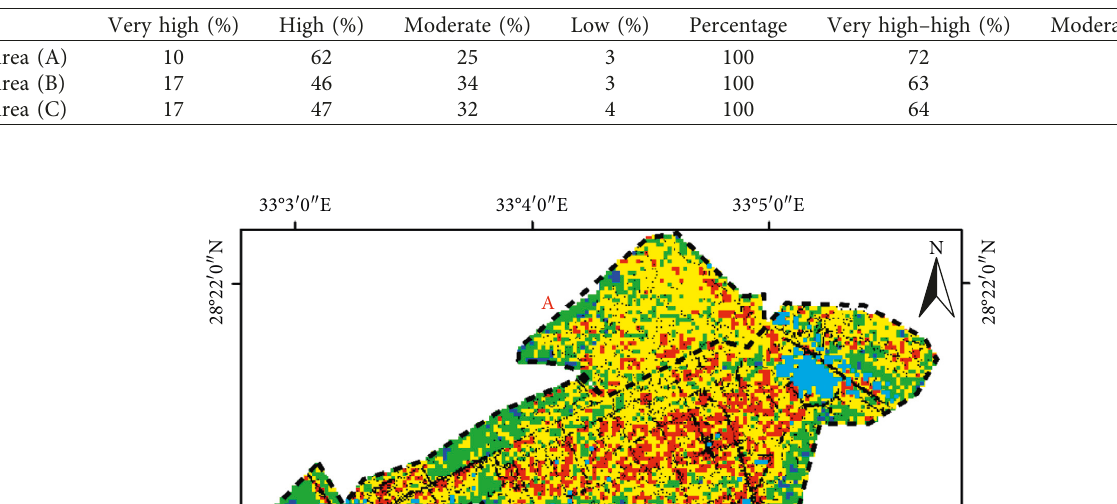
Table 6: Categorization percentage for each